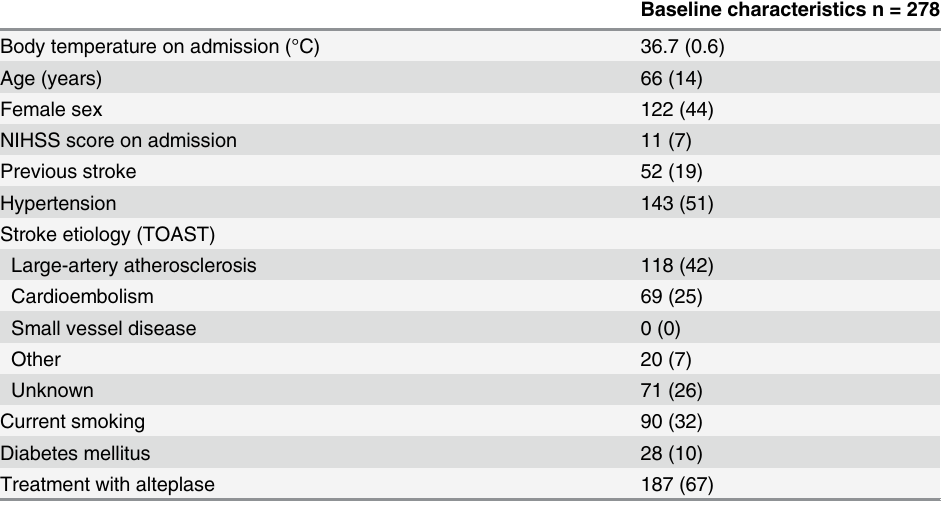
Table 1. Patient